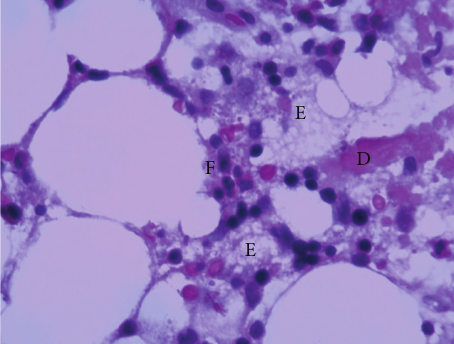
Figure 4: Bone necrosis (letter D), fat necrosis (letter E), and acute with chronic inflammatory cells (letter